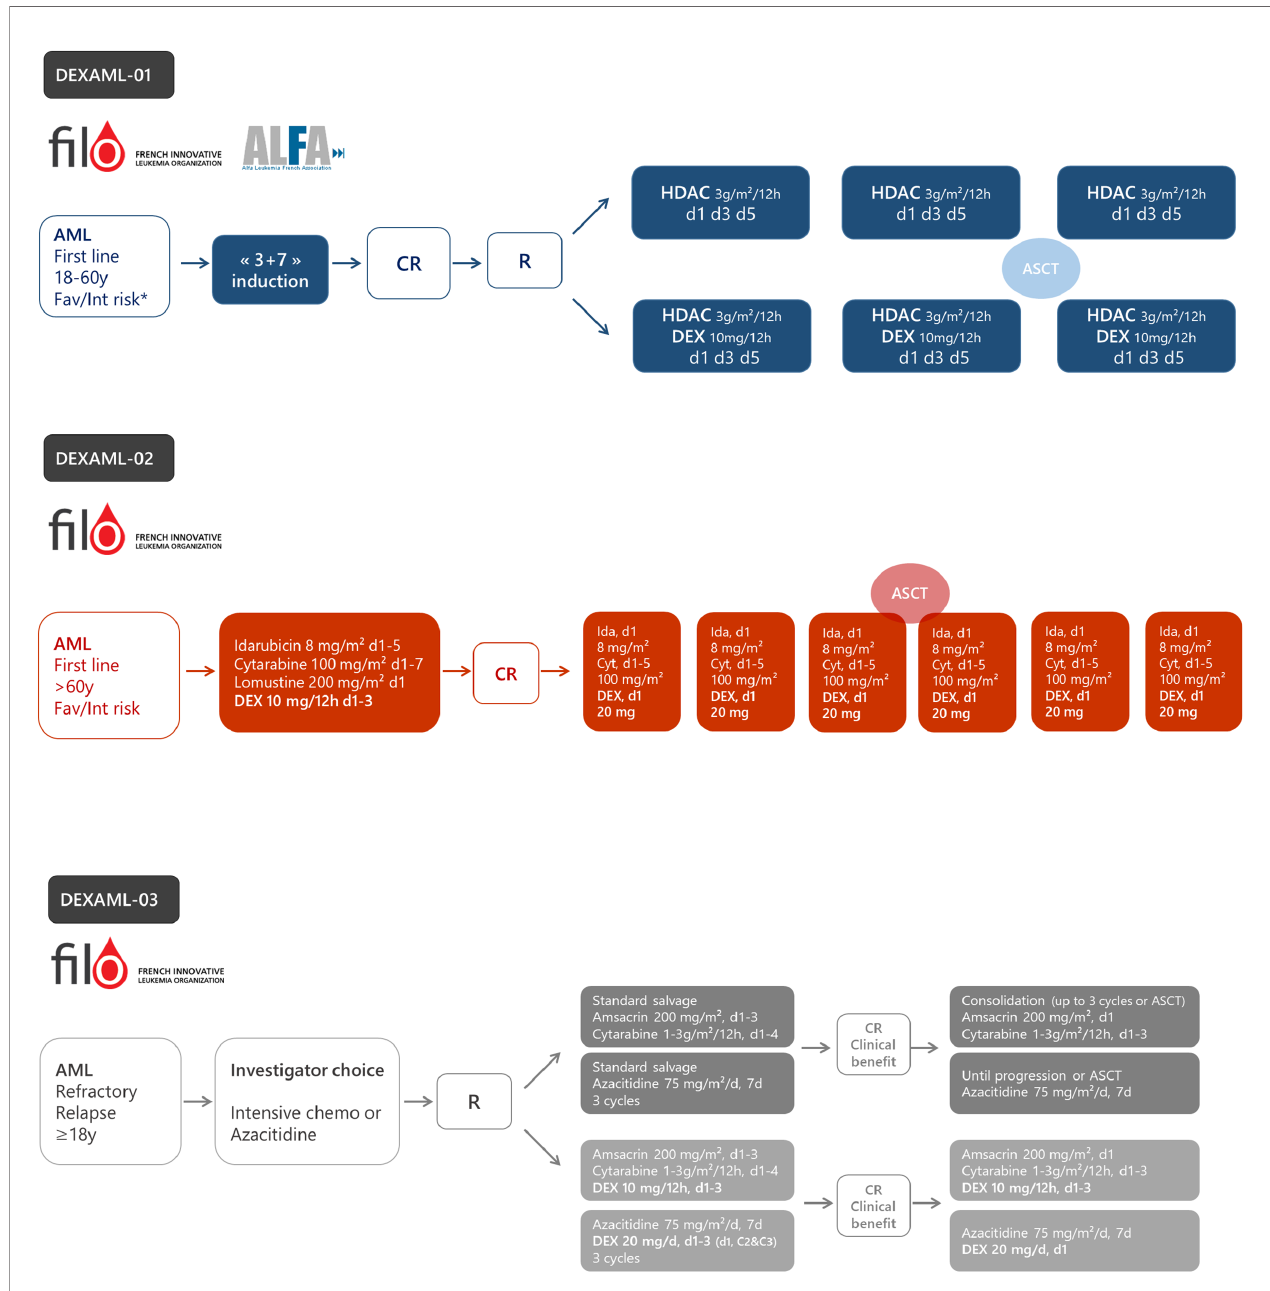
FIGURE 4 | The design of ongoing prospective trials to evaluate dexamethasone in acute myeloid leukemia (AML). DEXAML-01: patients (18 – 60 years) with favorable (fav) or intermediate (int) risk in fi rst complete response after induction chemotherapy. DEXAML-02: patients > 60 with favorable or intermediate risk in fi rst line treatment. DEXAML-03: patients > 18 years with refractory or relapsed AML. CR, complete response; R, randomization; HDAC, high dose cytarabine (3 g/m²/ 12 h on day 1, 3, and 5); DEX,